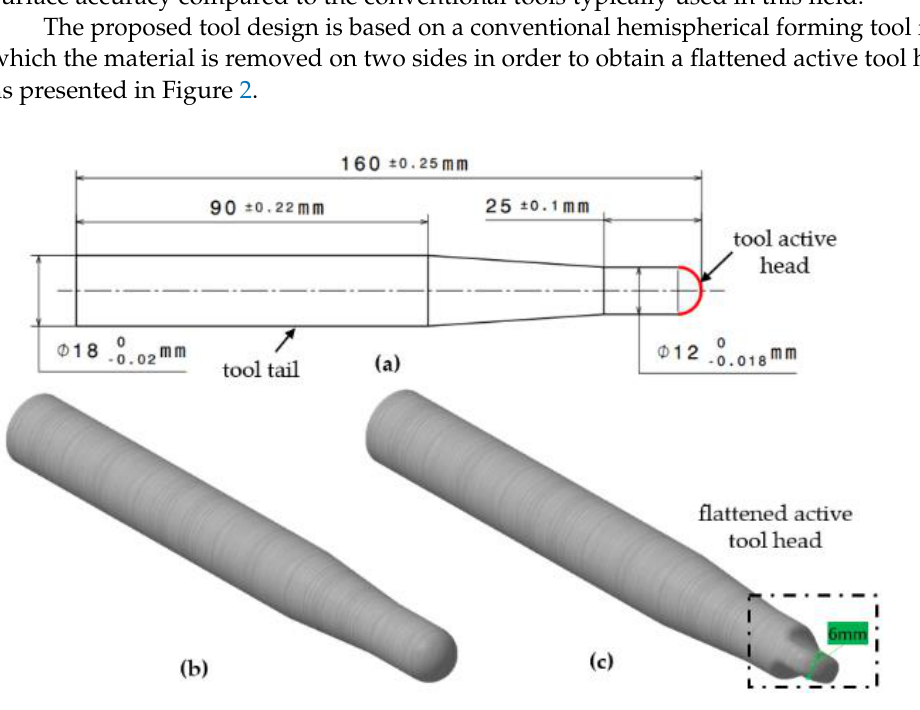
Figure 2. Shape and dimensions of the forming tools, adapted with permission from ref. [5], ( a ) tool dimensions; ( b ) conventional tool; ( c ) circumferential hammering tool.